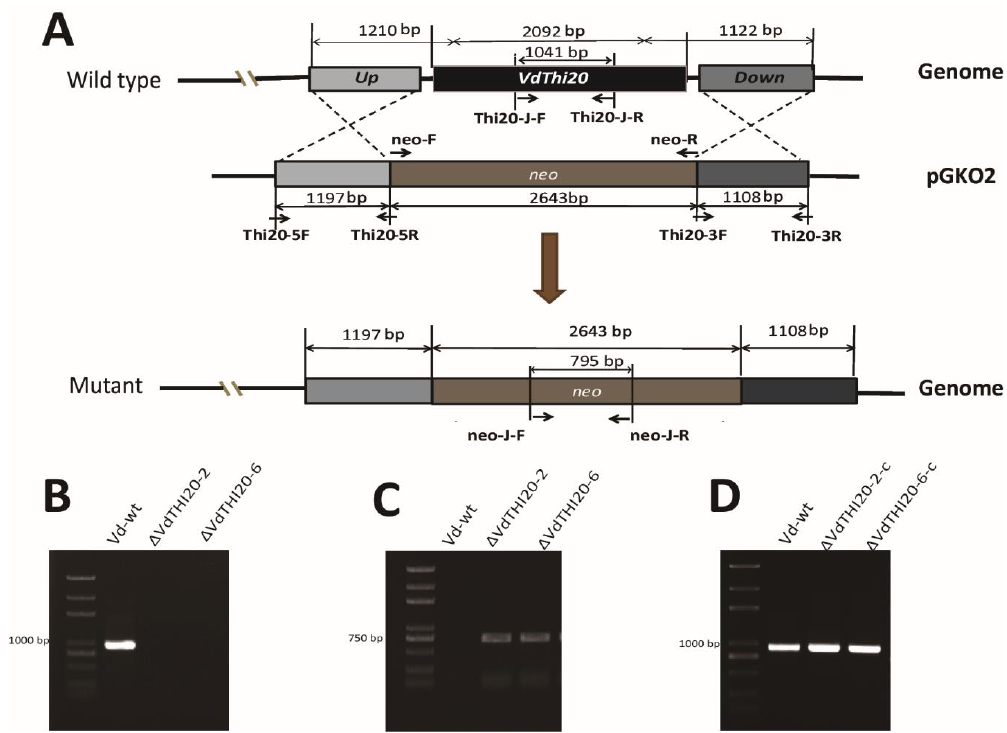
Figure 2. Schematic of the VdTHI20 gene knock out vector design and complemented ΔVdTHI20 mutant strains. ( A ) Construction scheme designed for the VdTHI20 gene knockout vector.